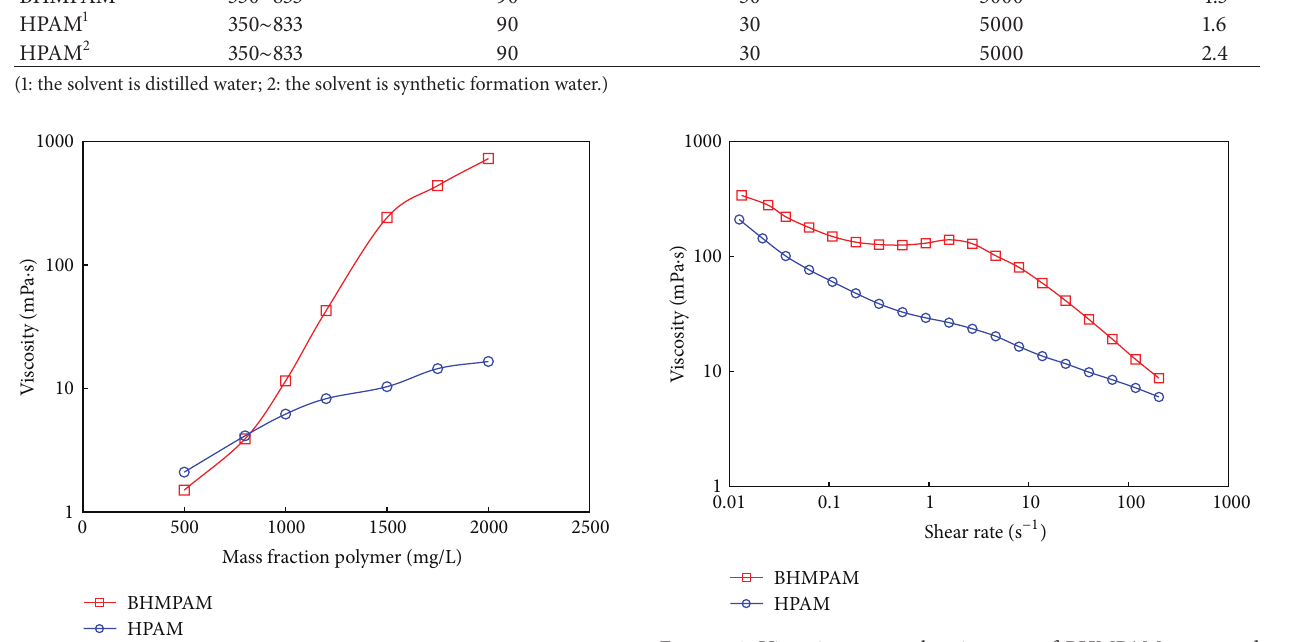
Figure 4: Viscosity versus shearing rate of BHMPAM compared to HPAM in synthetic formation water (concentration of both polymers: 1750mg/L).